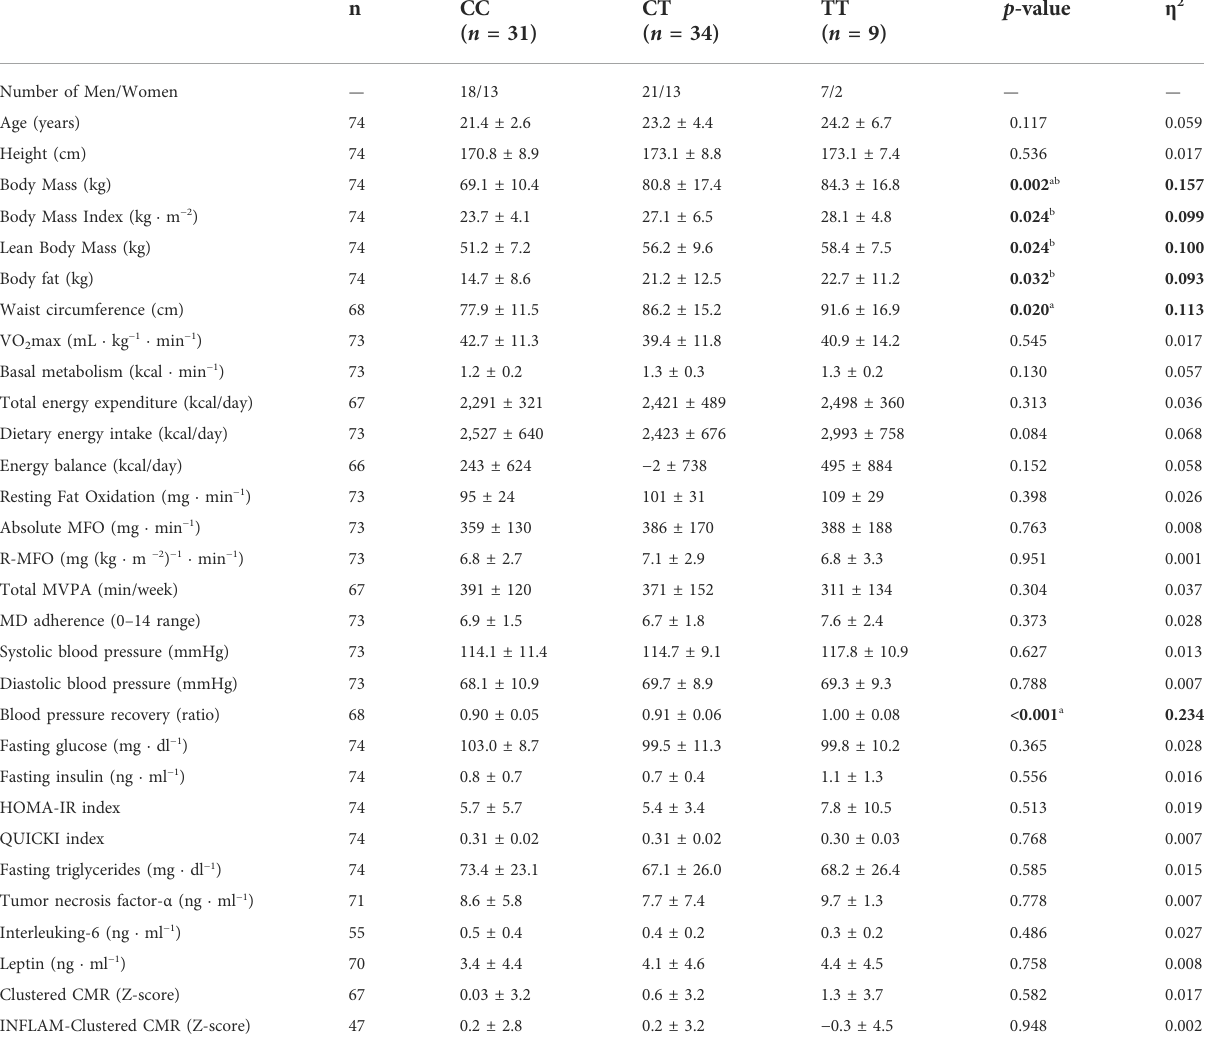
TABLE 2 Differences between the three PPARGC1A gene rs8192678 C > T polymorphisms in the analyzed variables.